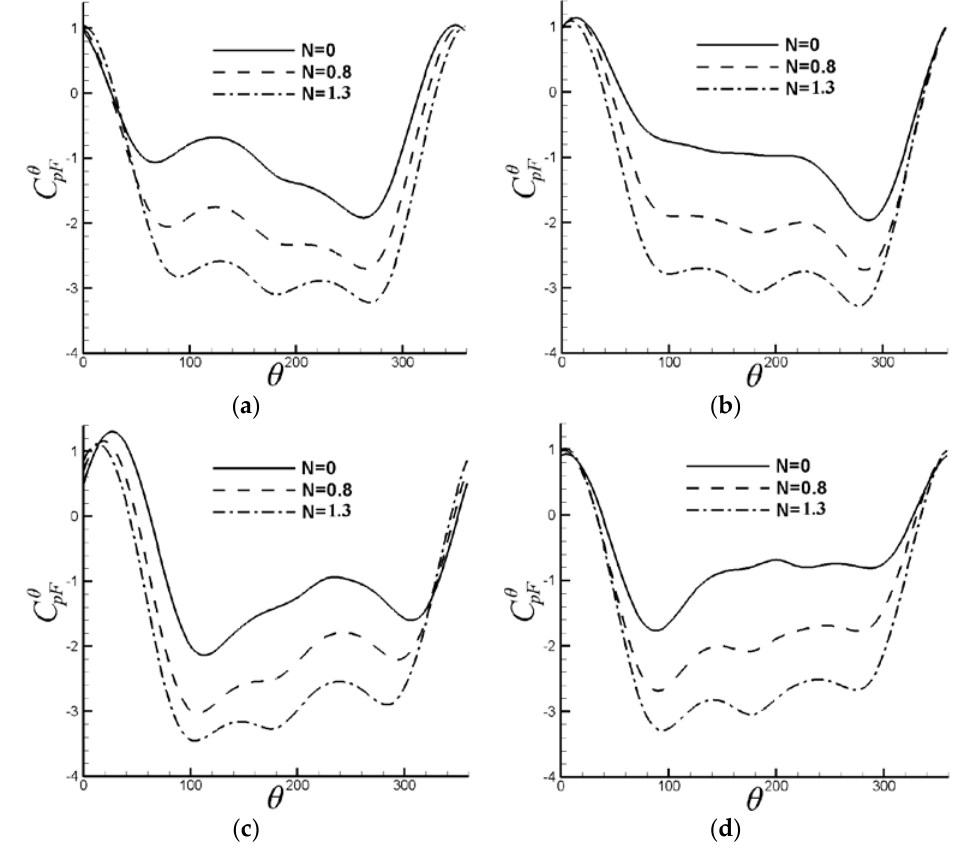
θ C on the surface of cylinder with different values of interaction Figure 9. Distribution of Figure 9. Distribution of C θ on the surface of cylinder with different values of interaction parameter pF pF N for shear rate K = 0.2: ( a ) Time A; ( b ) Time B; ( c ) Time C; and ( d ) Time D. parameter N for shear rate 0.2 K = : ( a ) Time A; ( b ) Time B; ( c ) Time C; and ( d ) Time D. The inertial force C θ , resulting from the acceleration of the cylinder, has influence on the pressure pV distributions as well. The distributions of C θ related with the inertial force for different values of pV interaction parameter N are depicted in Figure 10. When N = 0, the additional lift generated by the 2 l ( t ) background vortex caused by the shear incoming flow leads to the acceleration d at Time B being dt 2 larger than that at Time D. Namely, the inertial force at Time B is larger than that at Time D. When N > 0, the inertial force decreases with the increase of the values of Lorentz force while the inertial force at Time B is still larger than that at Time